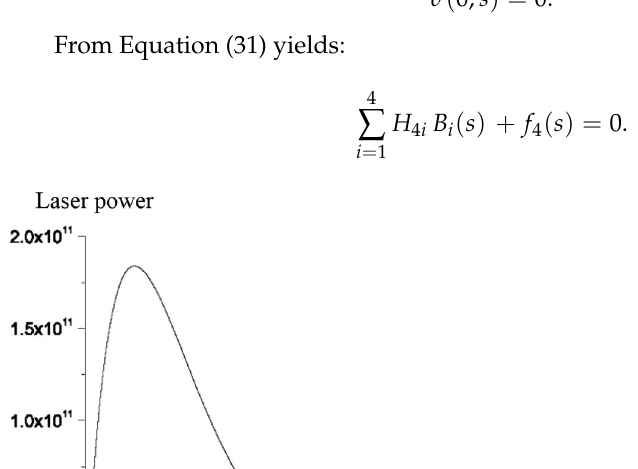
Figure 1. Temporal profile of the laser